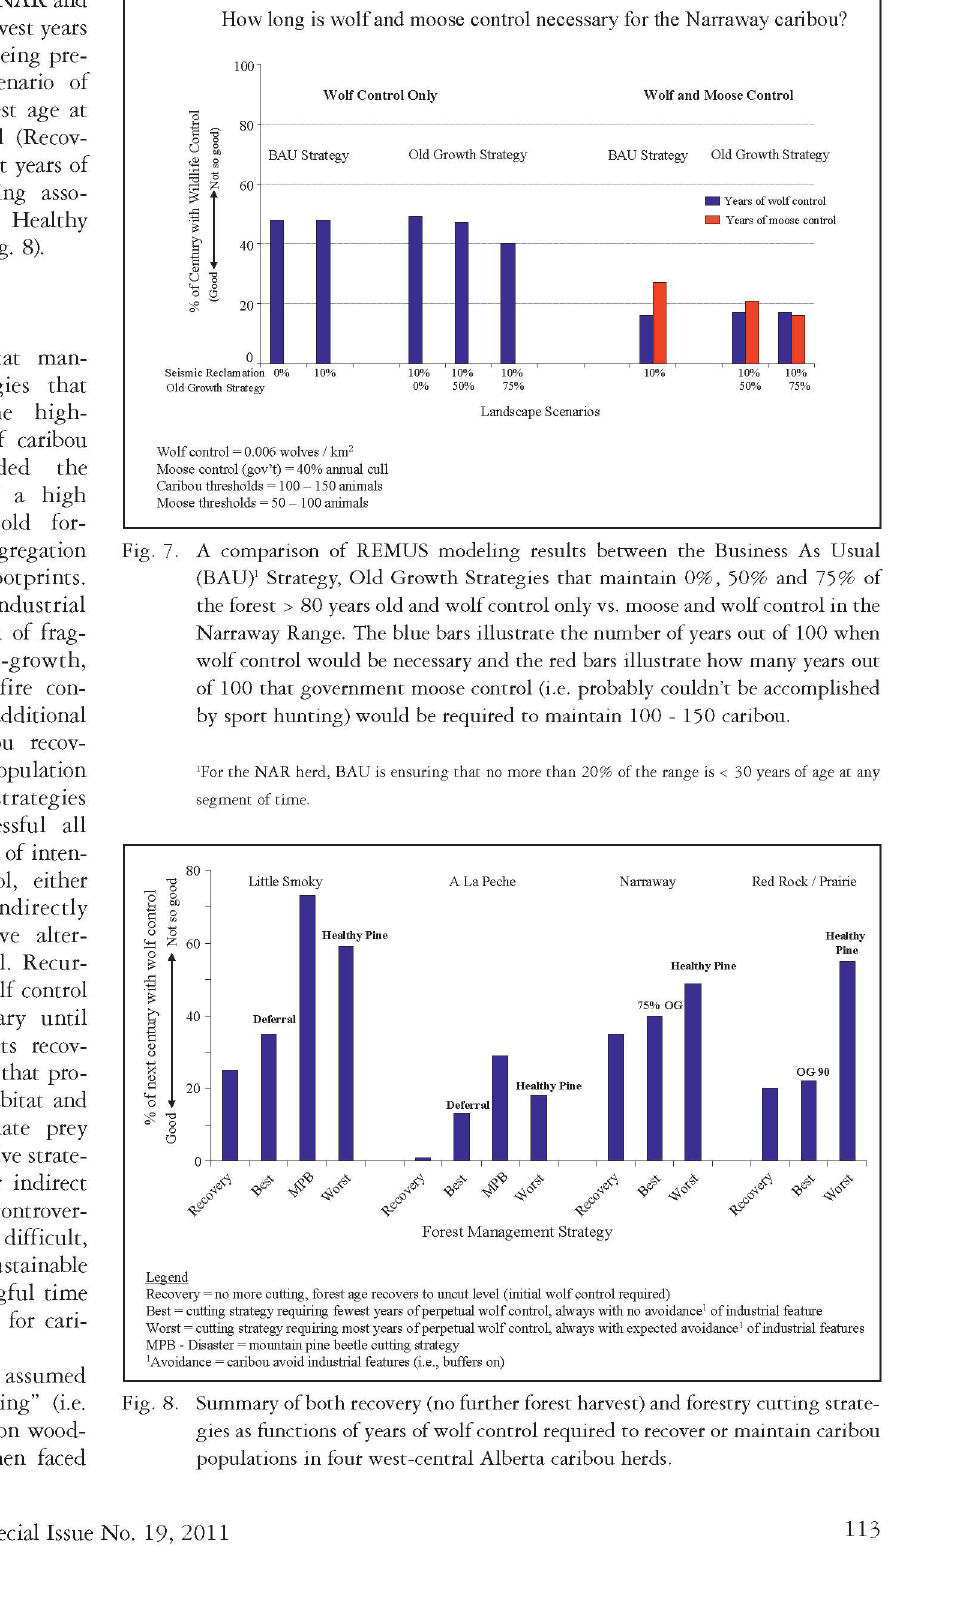
Fig. 8. Summary of both recovery (no further forest harvest) and forestry cutting strate¬ gies as functions of years of wolf control required to recover or maintain caribou populations in four west-central Alberta caribou